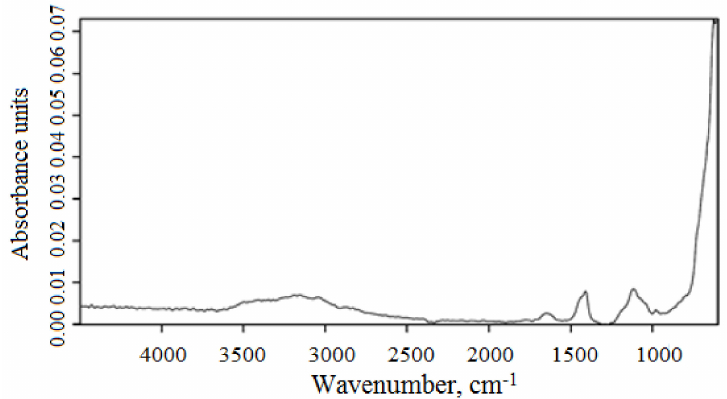
Figure 6. The IR spectrum of magnetic composite.